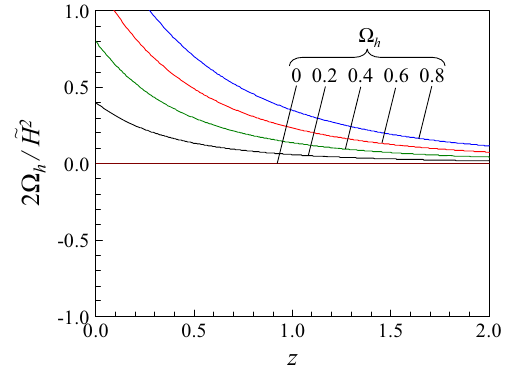
Fig. 4 Dependence of the parameter 2 (cid:8) h / ˜ H 2 on redshift z . Note that 2 (cid:8) h / ˜ H 2 is equivalent to X ≡ λ K / H 2 shown in Fig.